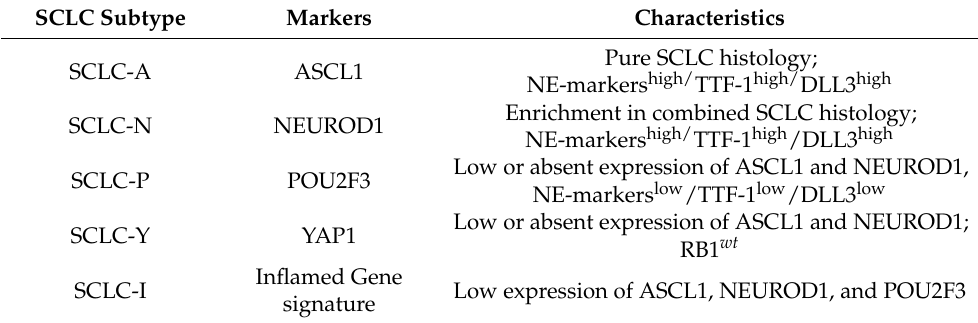
Table 3. Molecular classification of Small cell lung carcinoma (SCLC)